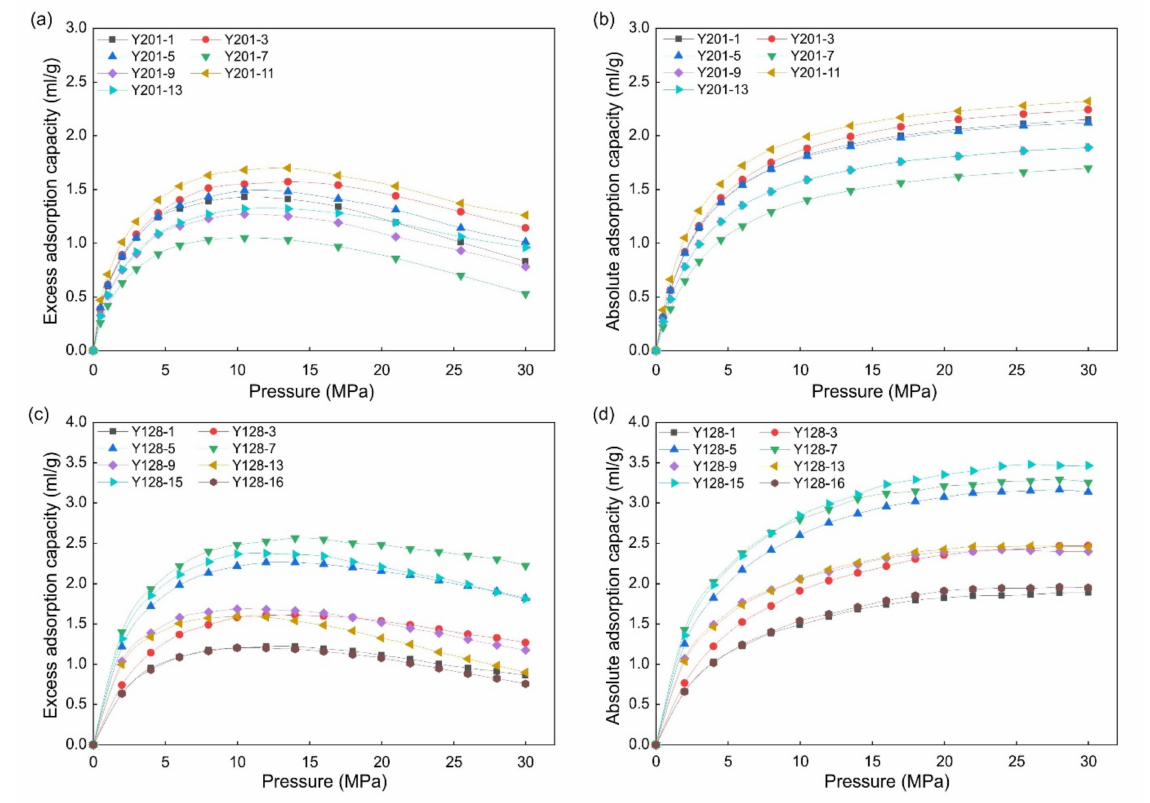
Figure 6. Excess and absolute adsorption isotherms of two representative wells (( a , b ): Well Y201; ( c , d ): Well Y128).